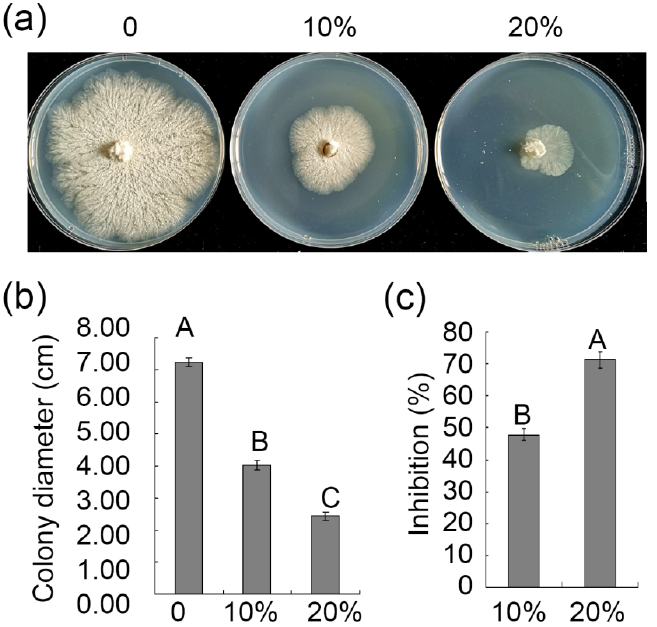
Figure 4. Effect of culture filtrate of ZZ1 on mycelial growth of V. pyri . ( a ) Inhibition of culture filtrate of ZZ1 on mycelial growth of V. pyri . The picture was taken at 6 days after inoculation on PDA medium. ( b ) Statistical analysis of colony diameter. ( c ) Inhibition of culture filtrate of ZZ1 on mycelial growth of V. pyri . Values are means ± SD from three replicates. Letters above the bars indicate statistical significance ( p < 0.01) based on Tukey’s test.